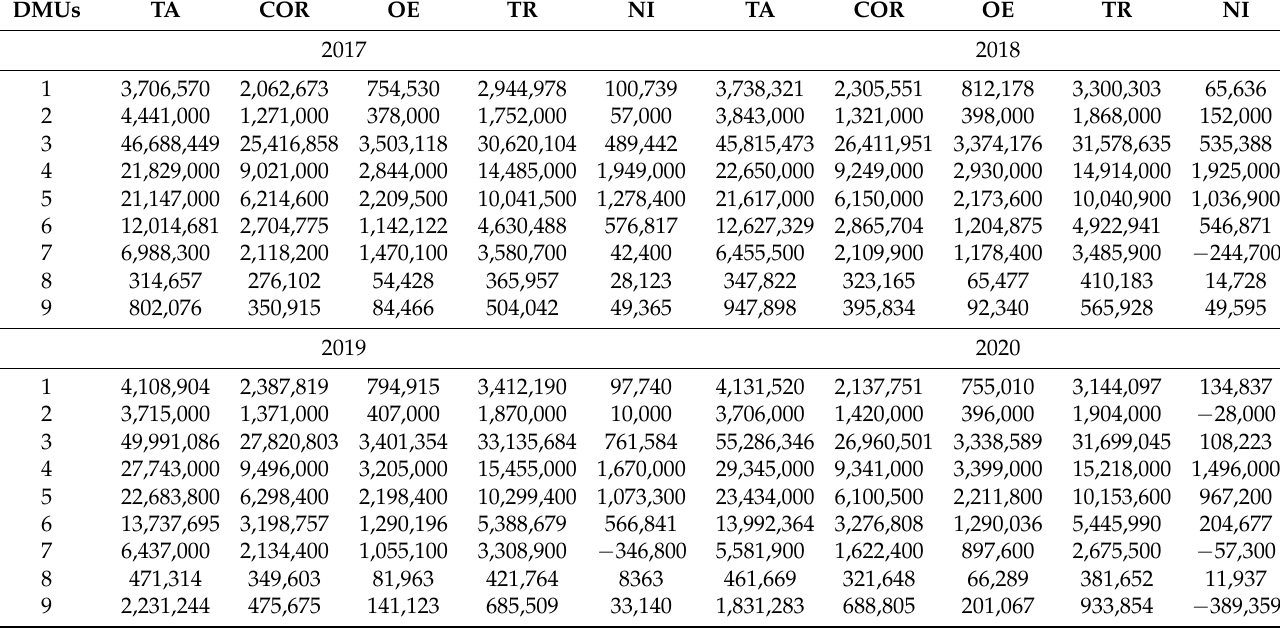
Table A1. Input and output data of DMUs from 2017 to 2020.